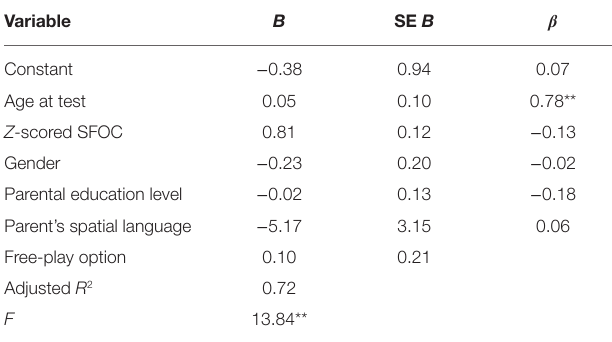
TABLE 5 | Summary of linear regression analysis for six variables (child’s age at test, gender, z -scored SFOC, parental education level, parent’s use of spatial language, and free-play option) predicting Spontaneous Focus on Numerosity.